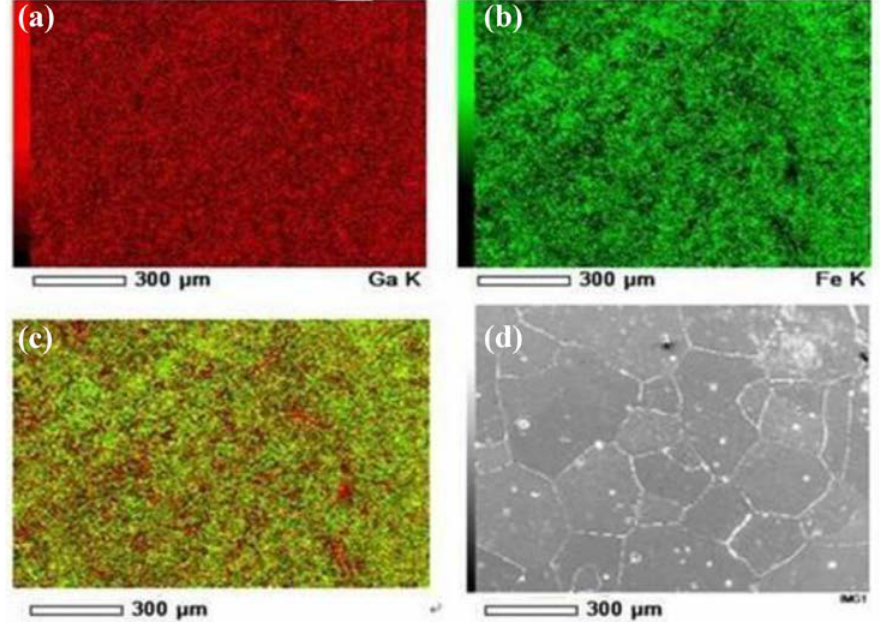
Figure 9. The surface morphology and EDS analysis of the as-cast Fe 85 Ga 15 alloy after polishing. ( a ) Ga; ( b ) Fe; ( c ) overlap of Ga and Fe; ( d ) surface